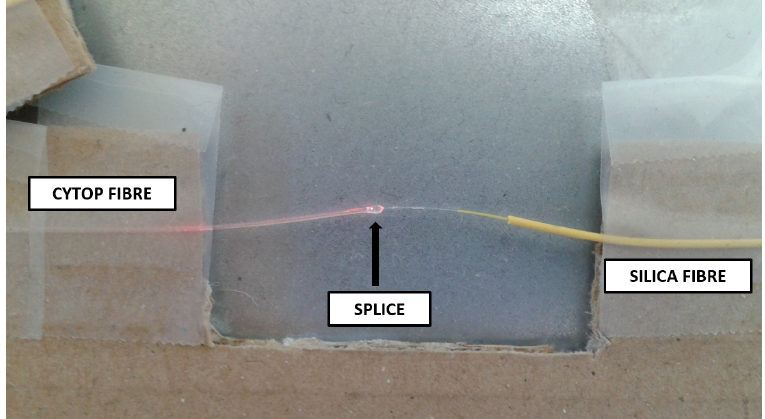
Figure 3. Physical changes in CYTOP fibre after 120kGy gamma radiation, illuminated using a 632 nm light